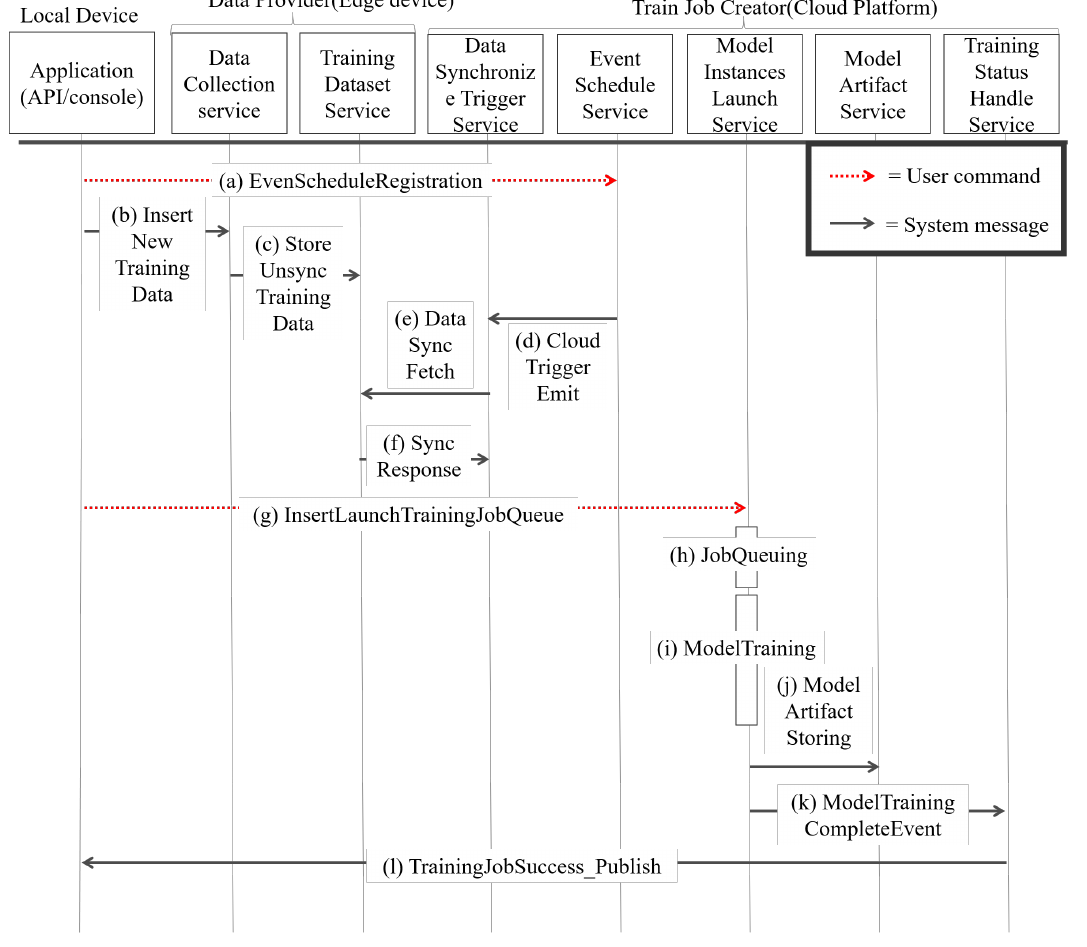
Figure 5. The training procedure on the MiniDeep